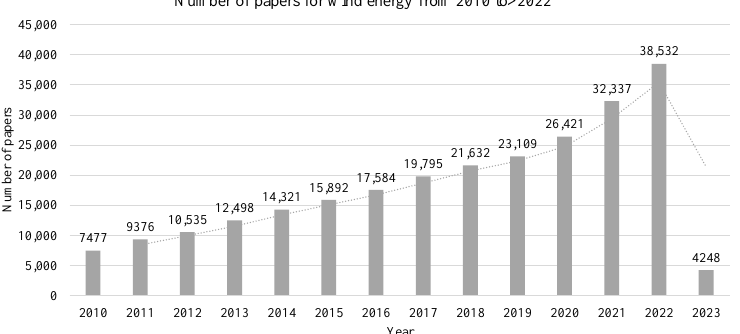
Figure 7. Research paper publication trends in wind energy (2010–2022). The dotted line represents the moving average of the published